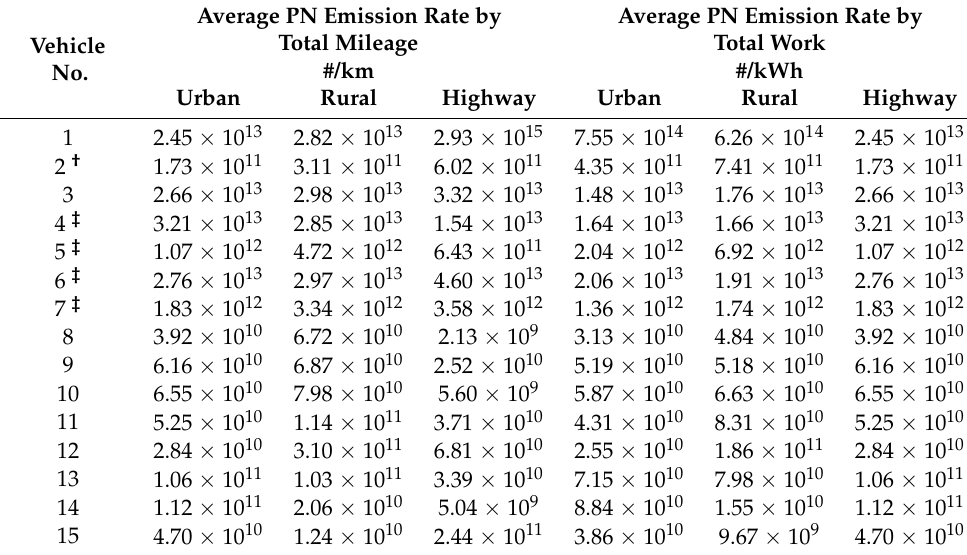
Table A2. Urban, rural and highway integrated emissions of all PEMS-tested vehicles.